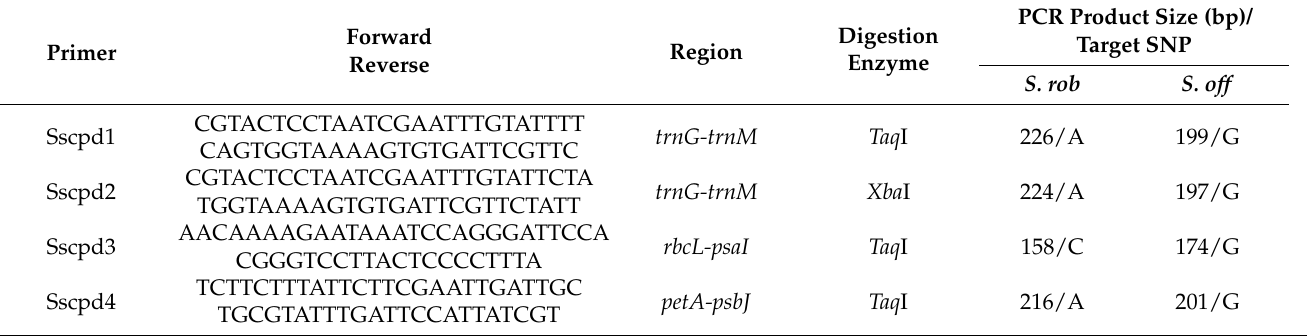
Table 3. dCAPS makers design based on SNPs between S. robustrum and S. officinarum